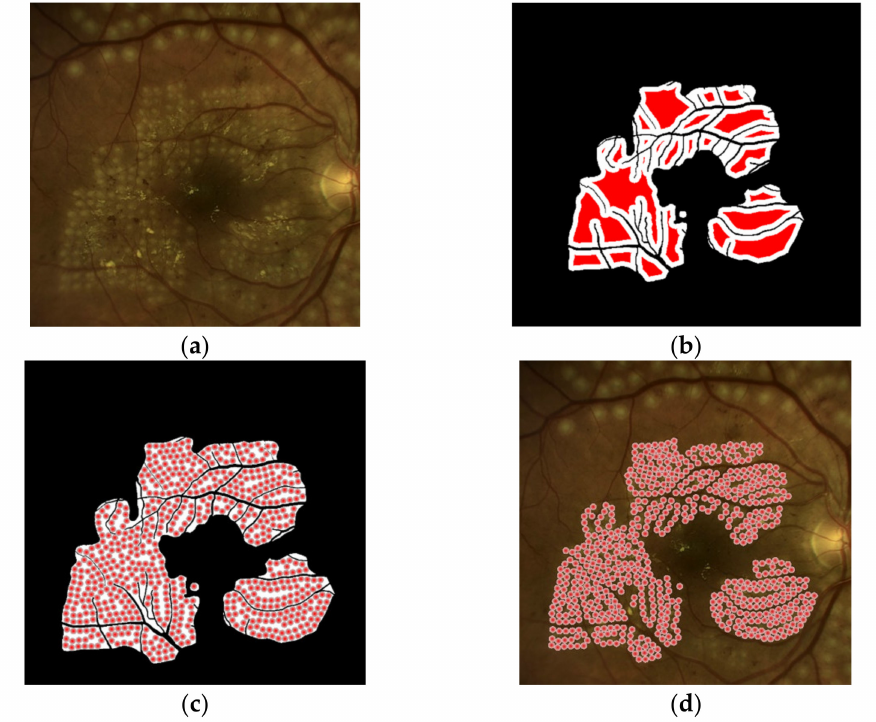
Figure 6. The approach for determining the optimal arrangement of coagulates: ( a ) fundus image; ( b ) segmentation into areas of interest; ( c ) automatic arrangement of coagulates; ( d) formation of photocoagulation